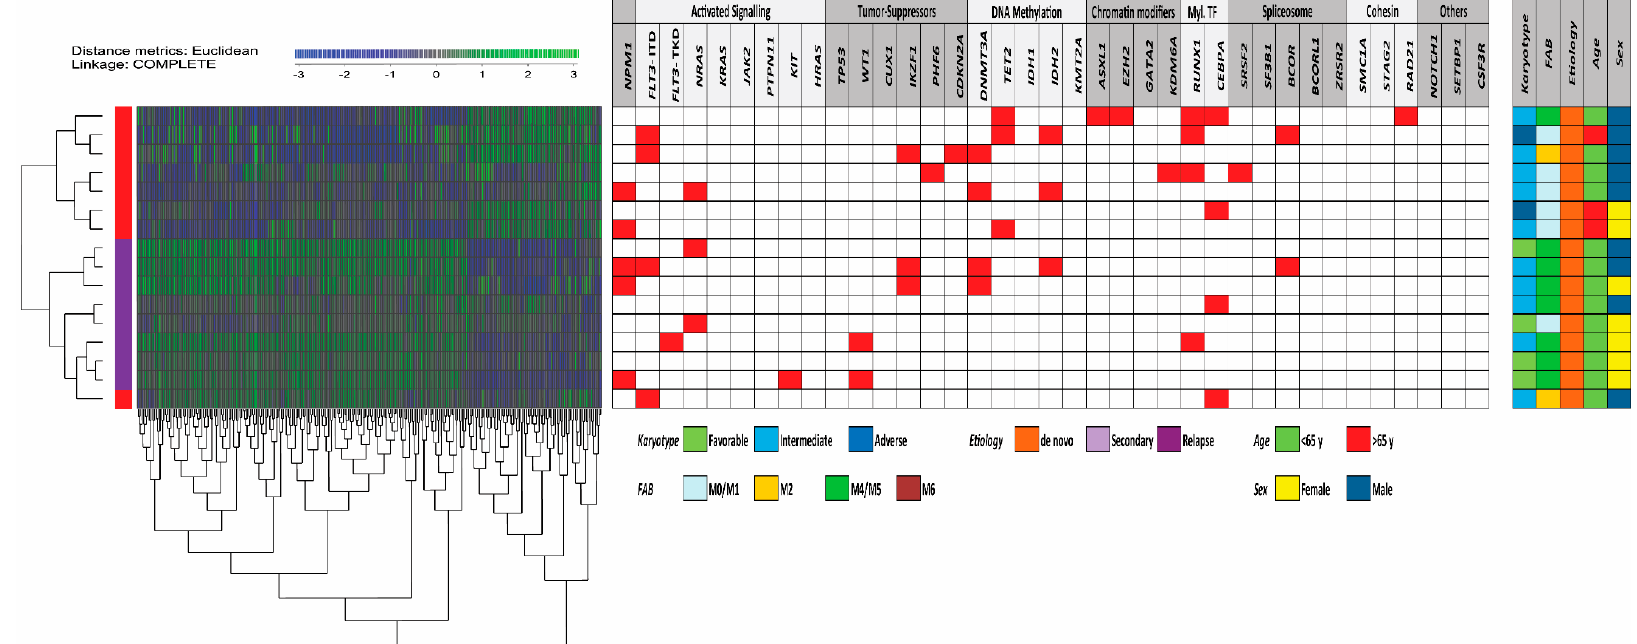
Figure 3. Identification of two main patient subsets based on proteomic differences of AML cells with high and low constitutive release. Eight of the 16 patients included in the proteomic studies belonged to the cluster characterized by generally high constitutive mediator release and the eight others showed low/intermediate secretion (Figure 2); 256 proteins differed significantly between these two groups. We performed an unsupervised hierarchical cluster analyses (Euclidean measure, and complete distance) based on the levels of these proteins, and the left part demonstrates the dendrogram and heat map; blue indicates low protein levels and green high levels. Two main clusters were then identified corresponding to the high and low/intermediate secretion patients except for one outlier patient (left column, red color indicating high release). As expected, the two main clusters were heterogeneous with regard to mutational frequencies (middle panel) and did not differ with regard to clinical or biological characteristics either (right panel).